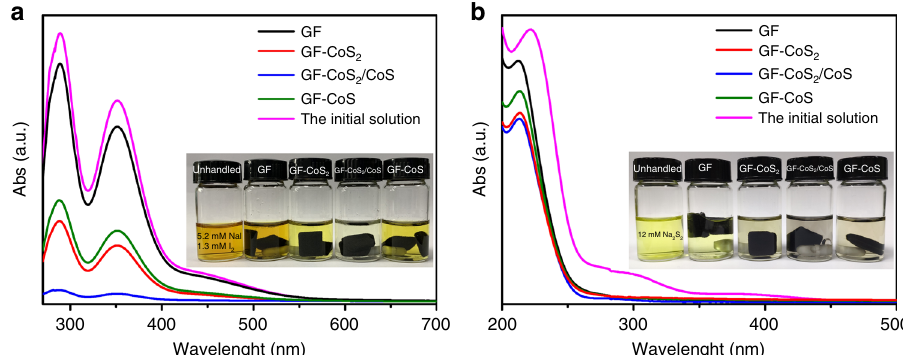
Fig. 3 Adsorption characterization of the electrode materials. Ultraviolet-visible spectra of the NaI + I 2 ( a ) and Na 2 S 2 ( b ) initial solutions and the solutions after interacting with graphite felt (GF), GF-CoS 2 , GF-CoS 2 /CoS, and GF-CoS, respectively. The loading amount of electrocatalysts onto GF is 1.0 mg cm − 2 . Inset: Visualized adsorption of NaI + I 2 and Na 2 S 2 and aqueous solutions on GF, GF-CoS 2 , GF-CoS 2 /CoS, and GF-CoS